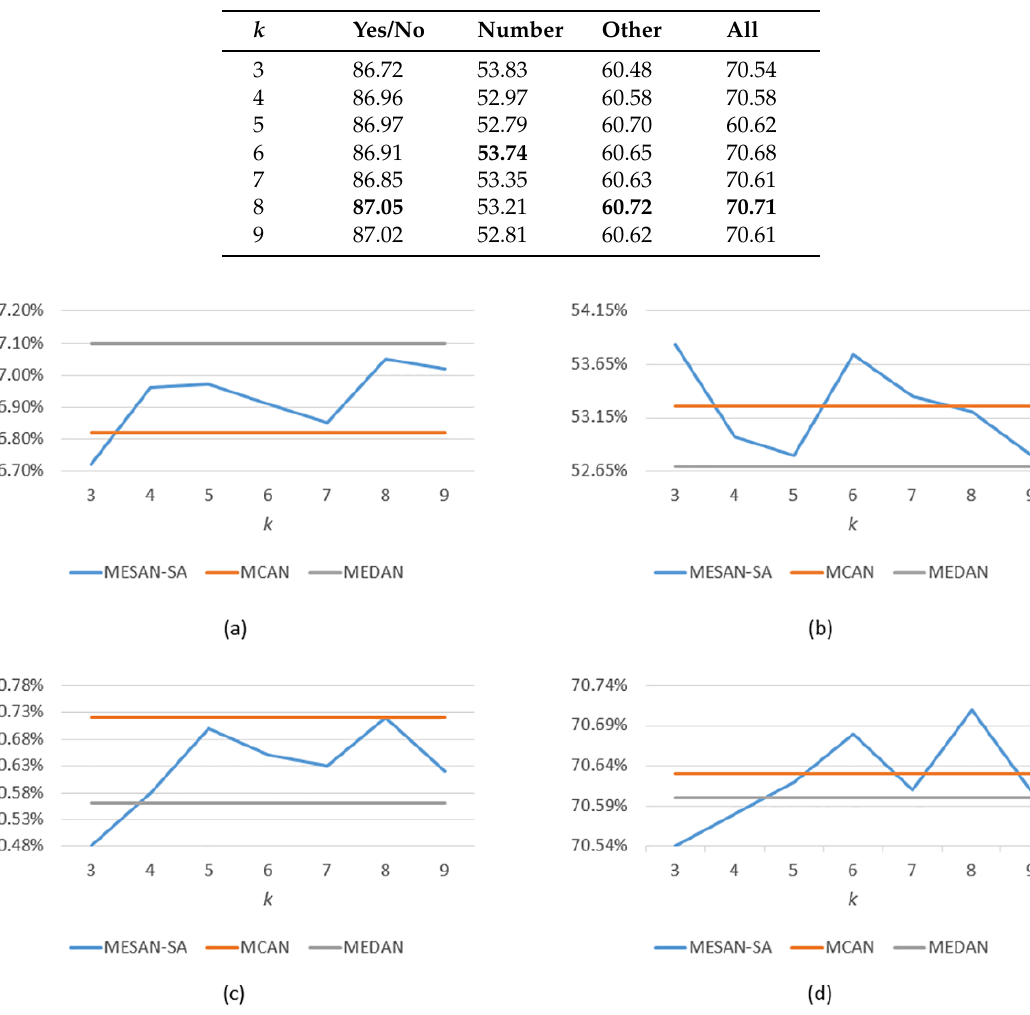
Table 1. Ablation results of MESAN-SA on visual question answering (VQA) v2 test-dev set. The best results are bold.